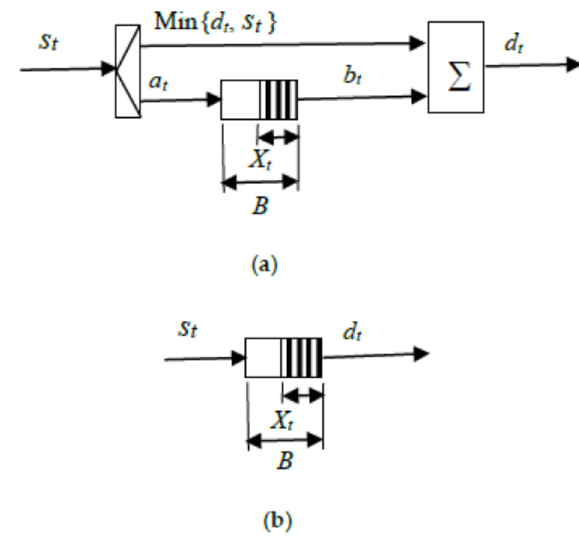
Figure 1. ( a ) Operation of renewable generator with storage system; and ( b ) Equivalent